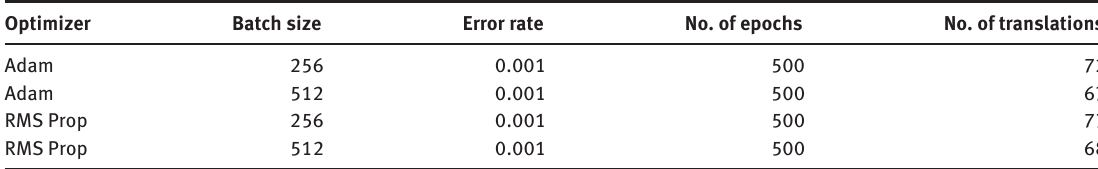
Table 1: Optimization of Hyperparameters. Optimizer